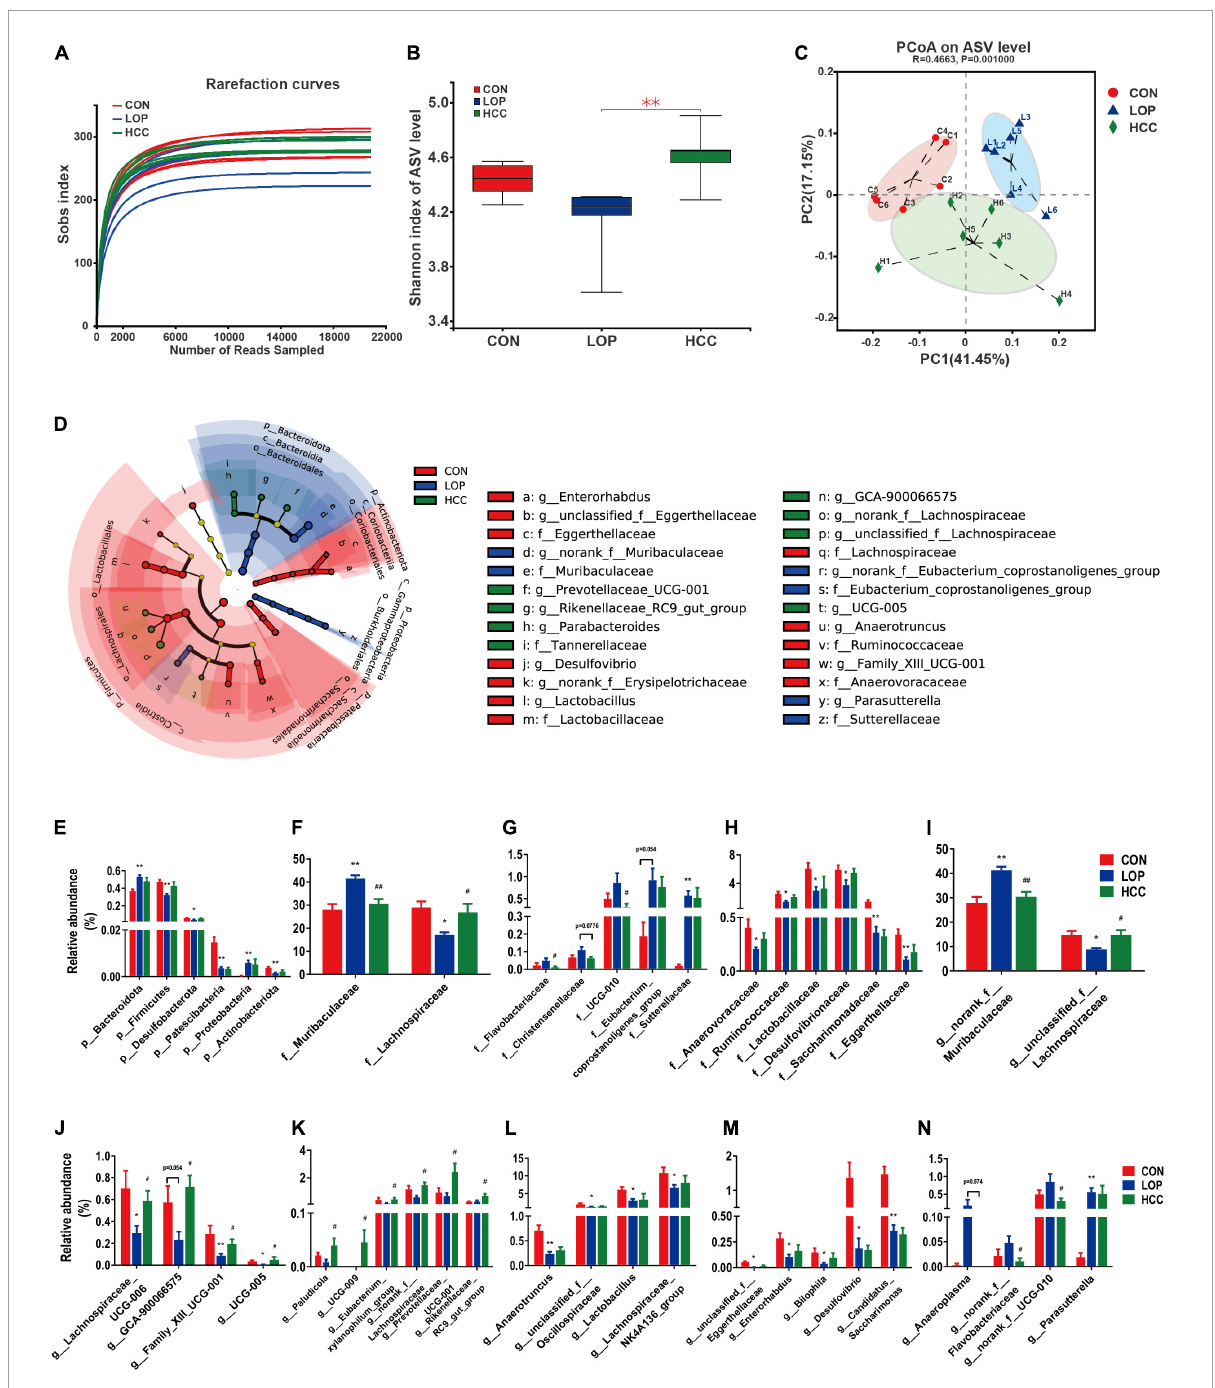
FIGURE5 HCC restores the LOP-induced gut microbial community structural and compositional shift. (A) The rarefaction curve of the Sobs index of each sample plateau at the ASV level. (B) Alpha diversity estimated by the Shannon index. (C) PCoA (principal coordinate analysis) plot based on weighted UniFrac distance. (D) Linear discriminant analysis effect size (LEfSe) analyses (LDA score of > 2.0). (E–N) Relative abundances of gut microbiota at the phylum, family, and genus levels, which were significantly affected by LOP or HCC, especially those reversed by HCC treatment. The data are expressed as the means ± SEMs ( n = 6). *, Compared with the CON group; #, compared with the LOP group. * P < 0.05, ** P < 0.01. # P < 0.05, ## P <